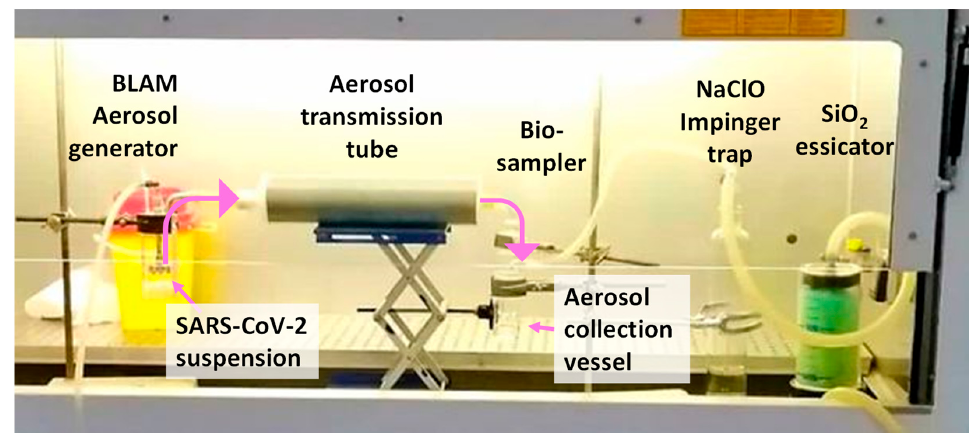
Figure 1. Bio-aerosol generation transmission and sampling train: The BLAM Aerosol generator hosts the SARS-CoV-2 suspension , receives an air flow from the AERO nebulizer pump (out of the figure), generates the bio-aerosol that is transmitted through the Aerosol transmission tube, and it is collected in the vessel of the Biosampler . The air flow is disinfected by passing into a NaClO impinger trap , and dried by a SiO 2 dessicator , before entering a BioBravo pump (out of the figure) that sustains the sampling. Pink arrows show the path followed by SARS-CoV-2 aerosol.